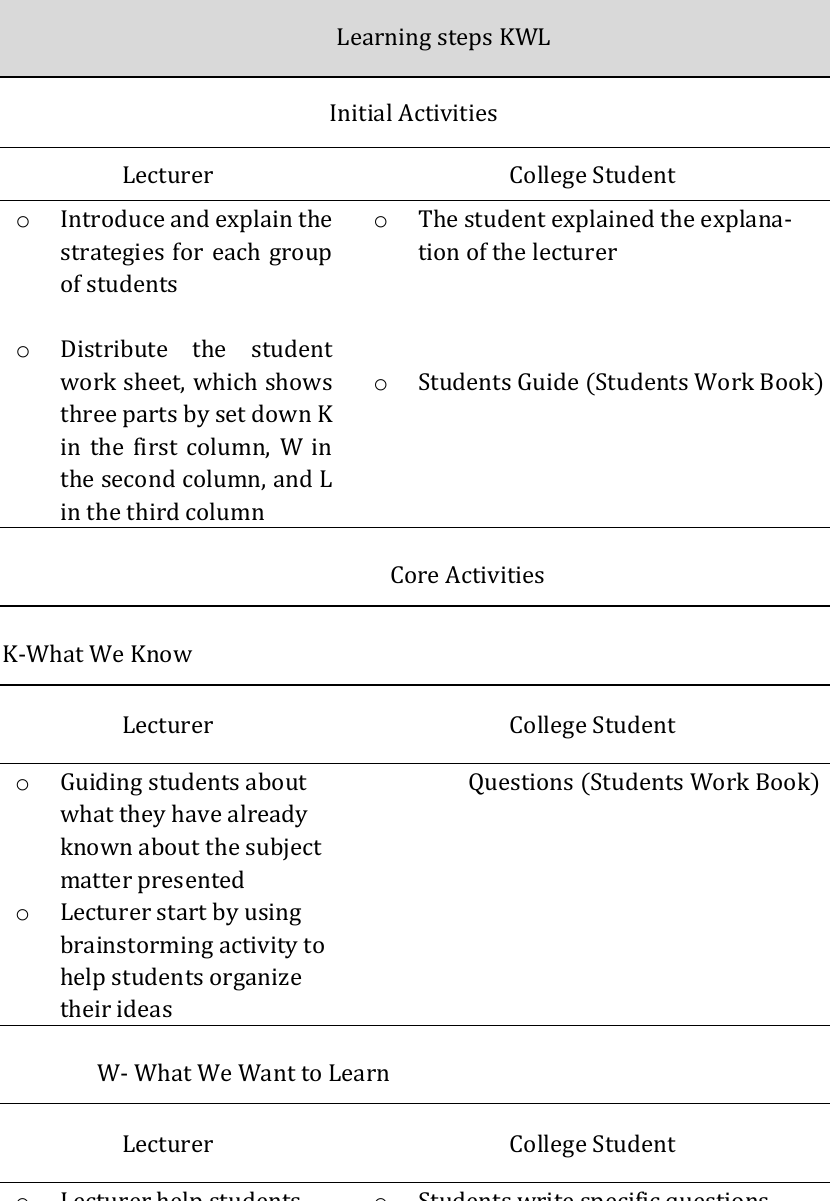
Table 2. Stage in KWL Learning